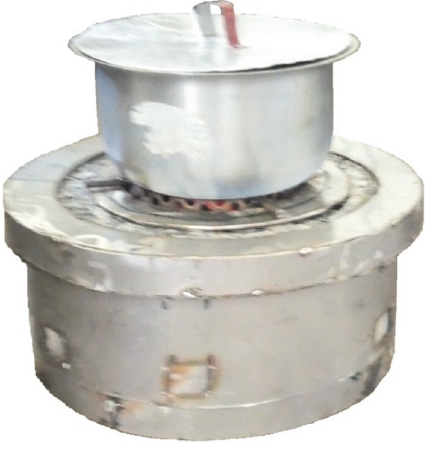
Figure 3: The stove made from granite